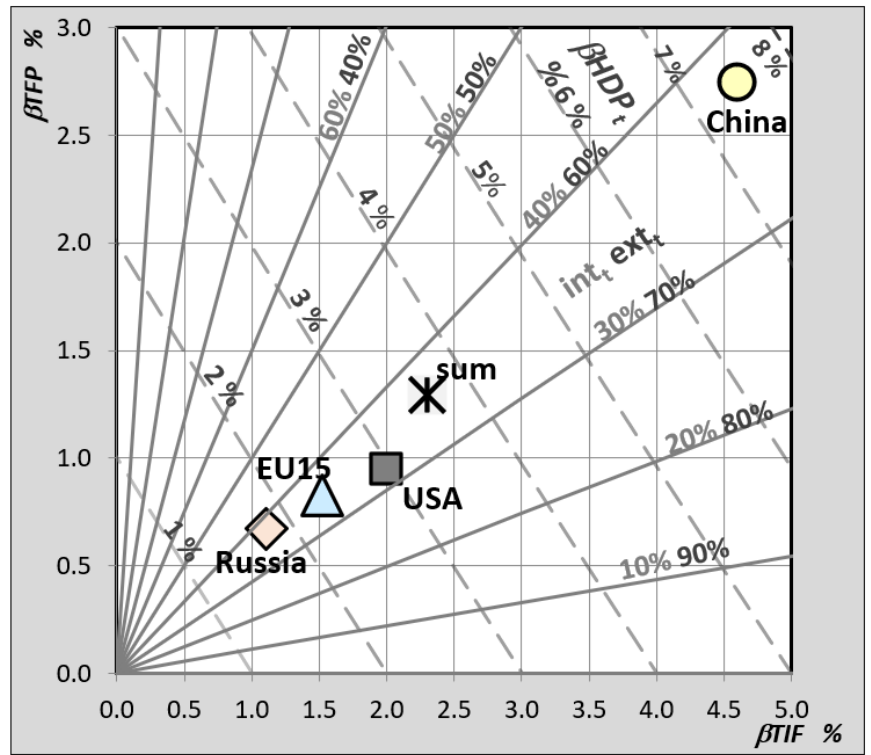
Figure 8. Qaulity of GDP development of anylyzed countries for the period of 1961 – 2021.